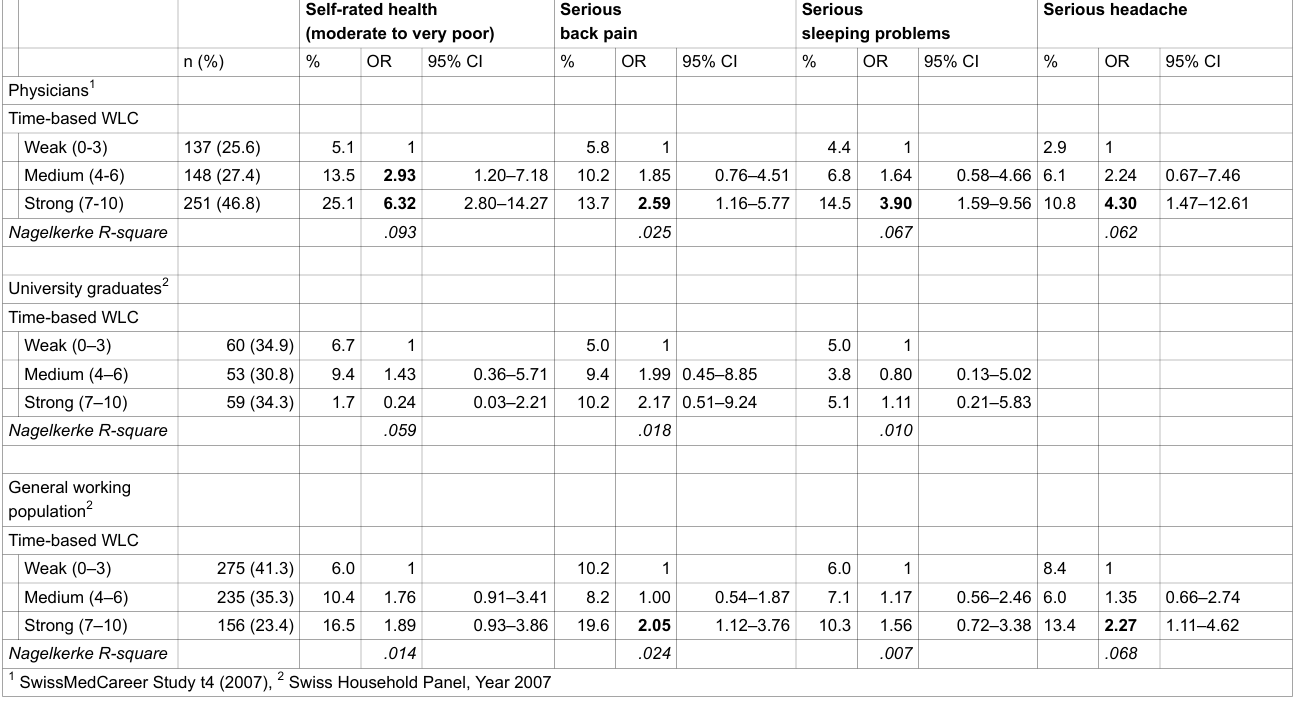
Table 3 Logistic regression from time-based work-life conflict (WLC)for different health outcomes – controlled for gender (not controlled for age because of the small age range of all samples); significant Odds ratios (OR) bold ( p ≤ .05).